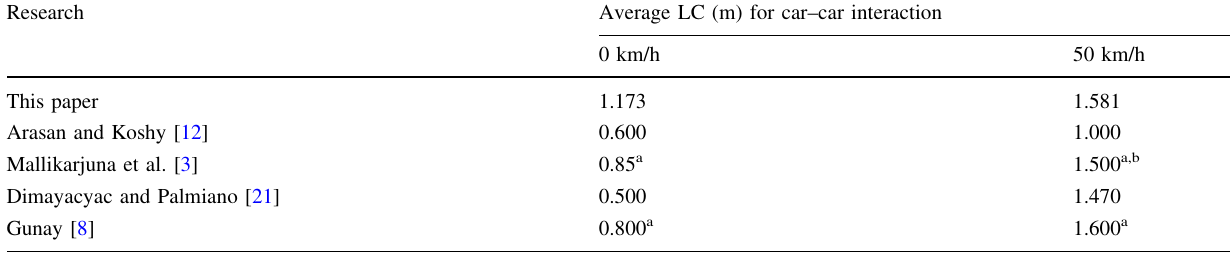
Table 7 Comparison of LC values with previous researches for car–car pair